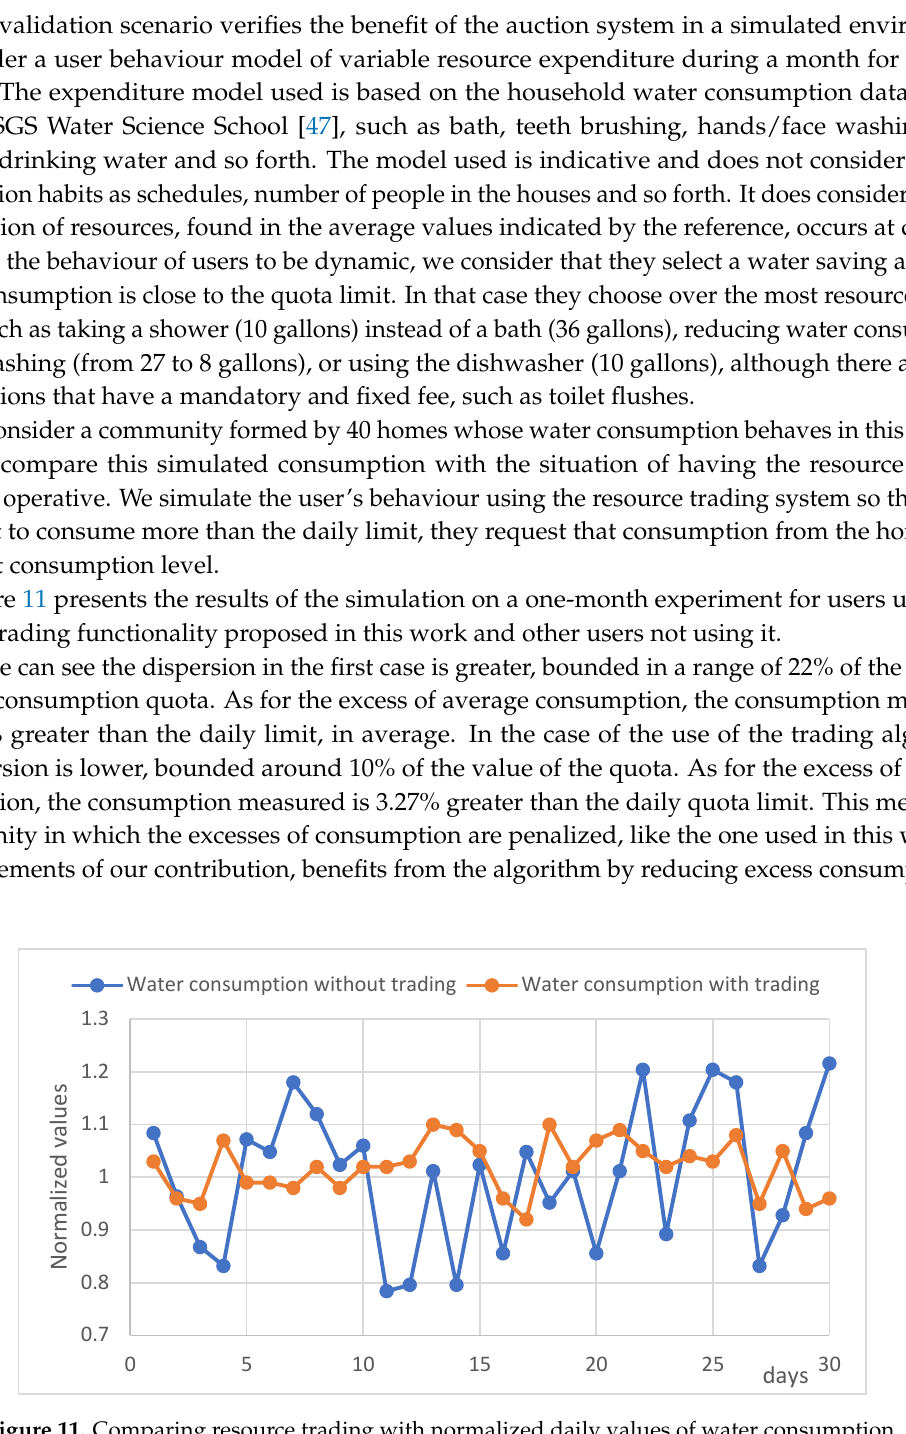
Figure 11. Comparing resource trading with normalized daily values of water consumption.